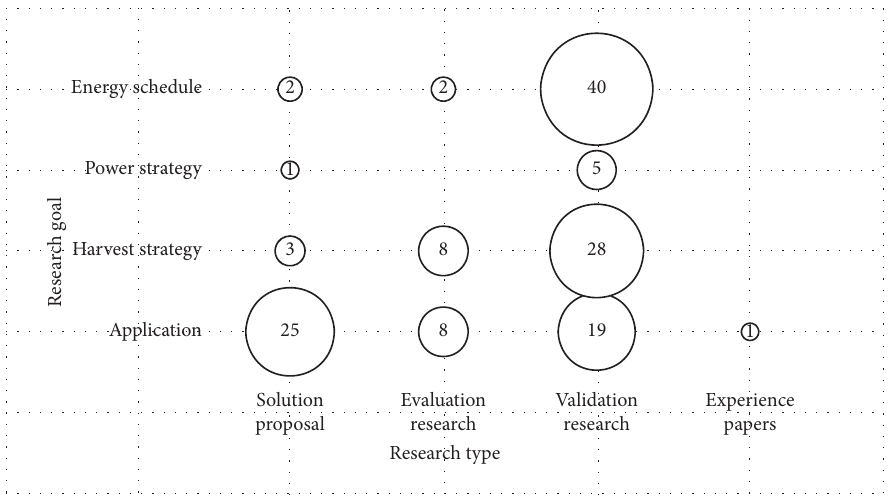
Figure 8: Research goals per research types.